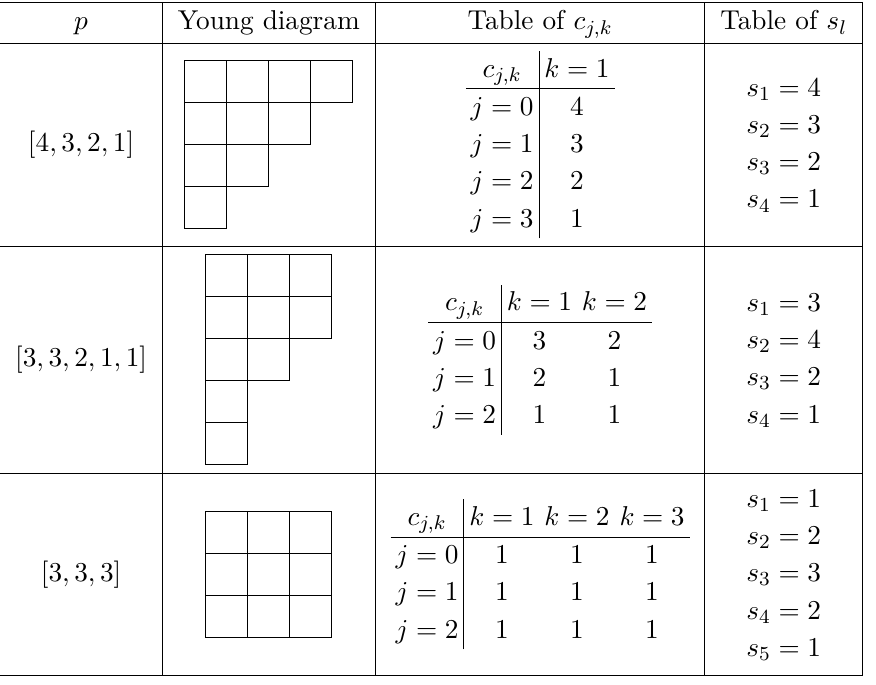
Figure 3 . Examples of the non-zero c j,k and s l for various integer partitions p